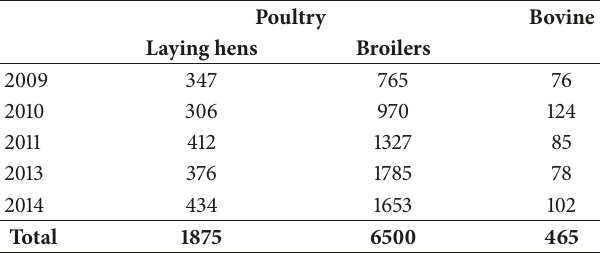
Table 1: Sample distribution by